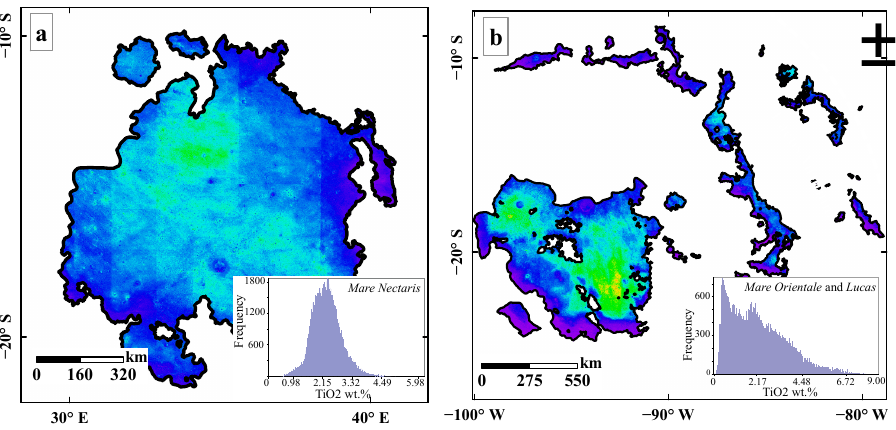
Figure 17. TiO 2 contents of Mare Nectaris ( a ), and Mare Orientale and Lucas within the Orientale Basin ( b ). Large impact events disturb the lunar crust of the target region and excavate materials from the deep parts of the Moon. Maunder (Figure 18a,b) is a complex crater of the Eratosthenian period, with a central peak [1]. The diameter of Maunder crater is approximately 55 km, and this impact event excavated materials to a depth of ~5 km. Topographic analysis of the Orientale impact structure suggests that the thickness of the melt sheet in the Orientale is approximately 15 km [48]. These materials likely compose the entire wall of Maunder and were brought to the surface from beneath. Thus, Maunder would have both excavated and brought up through structural uplift the deeper stratigraphy of the melt sheet of Orientale basin. The Rosse crater in the south of the Nectaris basin floor appears to be relatively fresh. The depth and the excavation depth of the Rosse crater are approximately 2.5 km and 1.0 km, respectively (Figure 18c,d). In addition, the maximum thickness of Mare Nectaris is over 1.5 km [49]. Thus, the formation of the Rosse crater only excavated the mare basalts. In the M3 composite spectral parameter image of the Maunder and Rosse craters, the yellow/orange colors indicate that the craters are a mixture of pyroxene and olivine-rich materials.